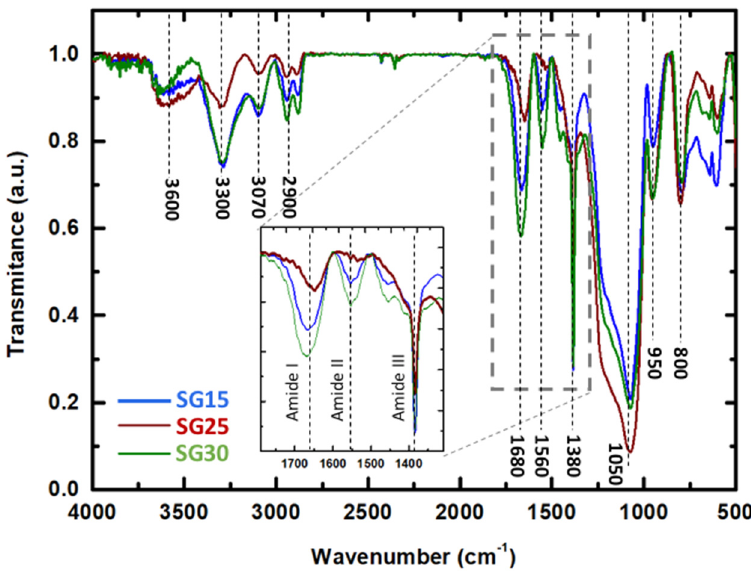
Figure 4. IR spectra of SG15, SG25, and SG30 aerogels. The inset shows a magnification of the inten- sity changes registered for the amide I, amide II, and amide III absorption bands. intensity changes registered for the amide I, amide II, and amide III absorption